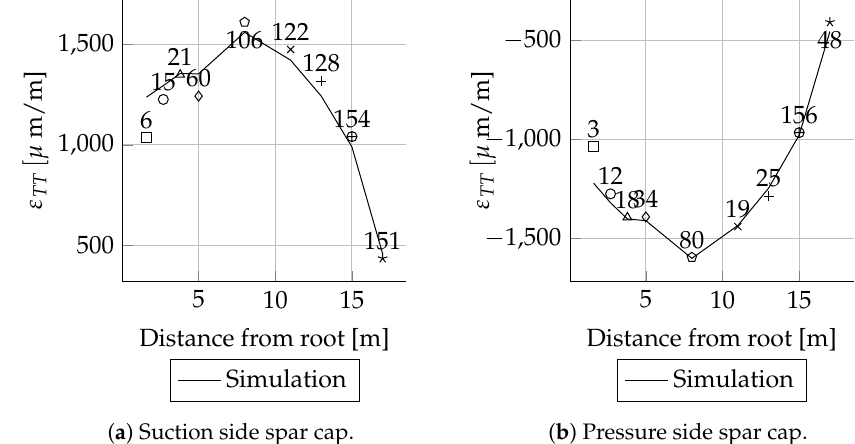
Figure A41. Strain comparison ε LL for Mymin load